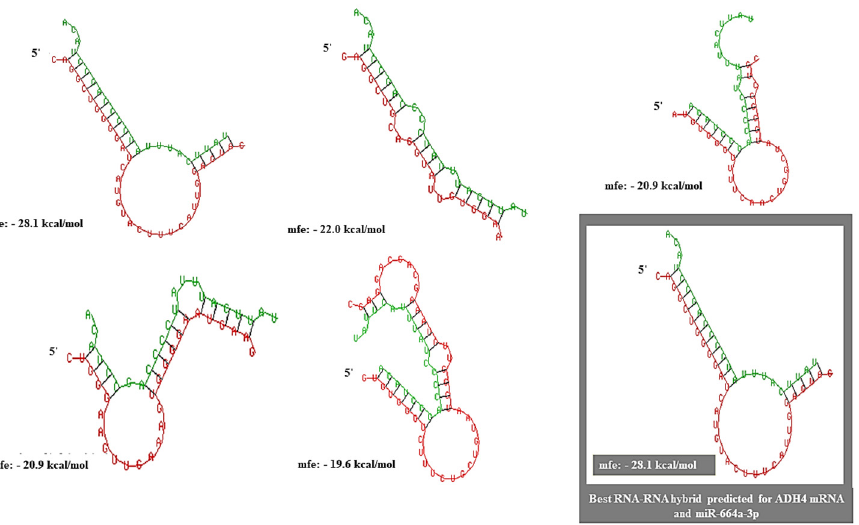
Figure 3. RNA heteroduplexes constructed for ADH4 mRNA and miR-664a-3p with the top five predicted miRNA–mRNA interactions. The best possible interaction had an MFE of − 28.1 kcal/mol.